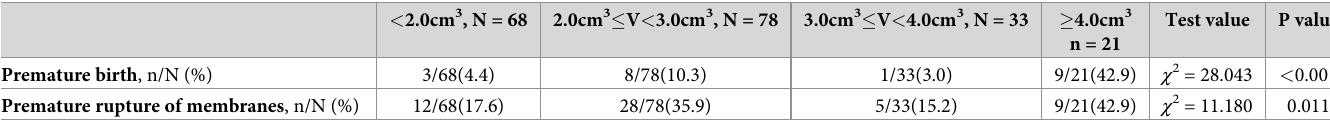
Table 6. The impact of cone volumes on preterm delivery and premature rupture of